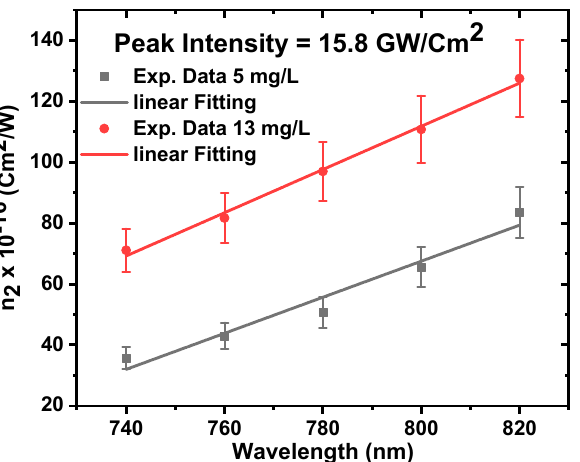
Figure 13. The nonlinear refractive index of ZnONPs colloids as a function of excitation wavelength at a constant incident peak intensity of 15.8 GW/cm 2 .